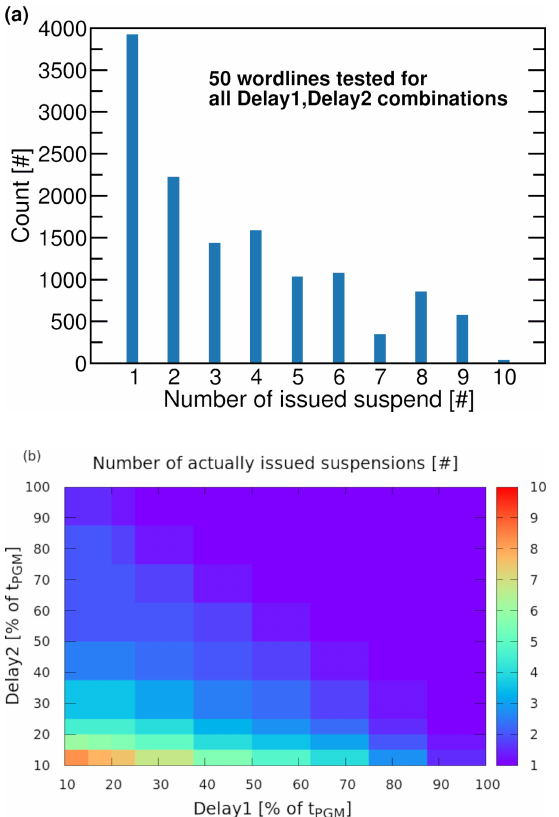
Figure 6. ( a ) Histogram of the actual number of issued suspensions considering all the delay combinations and for all 50 wordlines in the study. ( b ) Number of program suspensions as a function of Delay1 and Delay2